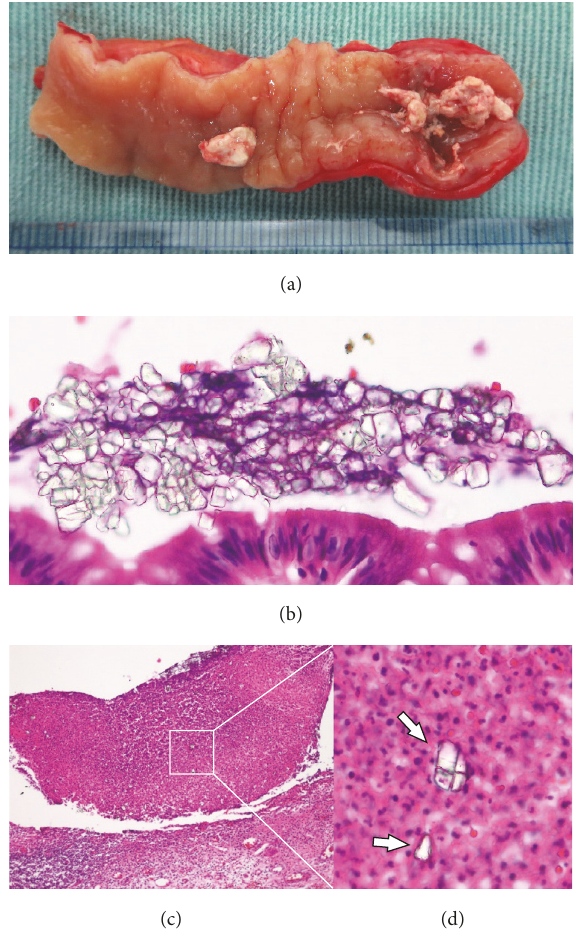
Figure 2: Resected specimen shows that the appendix contained a white, fragile fecalith. There was inflammation at the tip of the appendix (a). Crystal structure of barium sulfate on the mucosa (b) and in the infected fluid (c, d). Original magnification 200x (c), 400x (b,